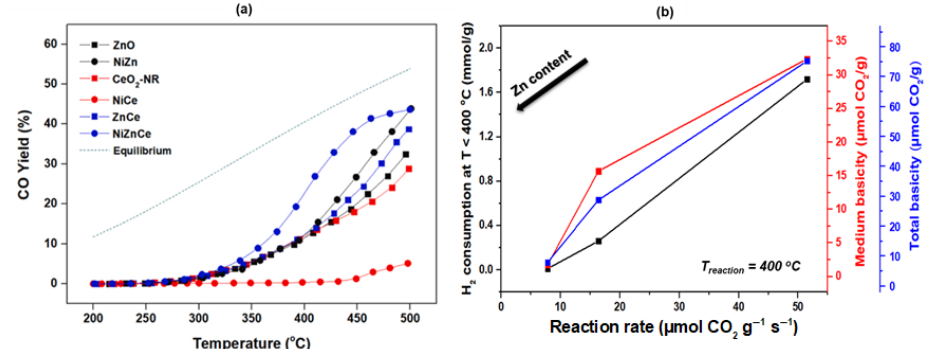
Figure 31. Temperature-dependent CO yield values ( a ) and correlation of reaction rate with reducibility and basicity ( b ) for Ni/CeO 2 -NR, Ni/ZnO and Ni/ZnO-CeO 2 -NR catalysts, where NR: nanorods. Adapted from Ref. [202]. Copyright© 2022, Elsevier.